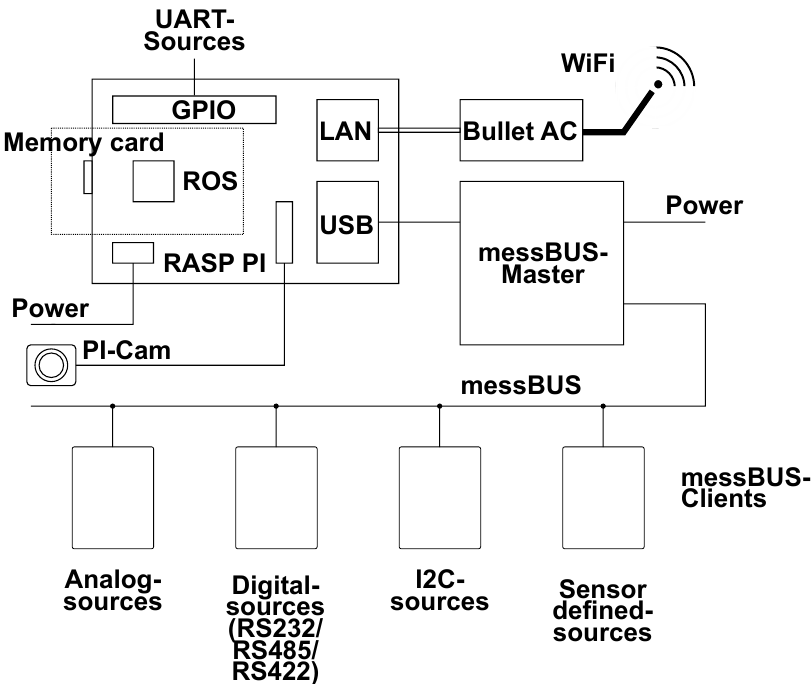
Figure 6. A clear representation of the MesSBAR data-acquisition system including our own devel- oped messBUS system connected to the single-board computer and its various